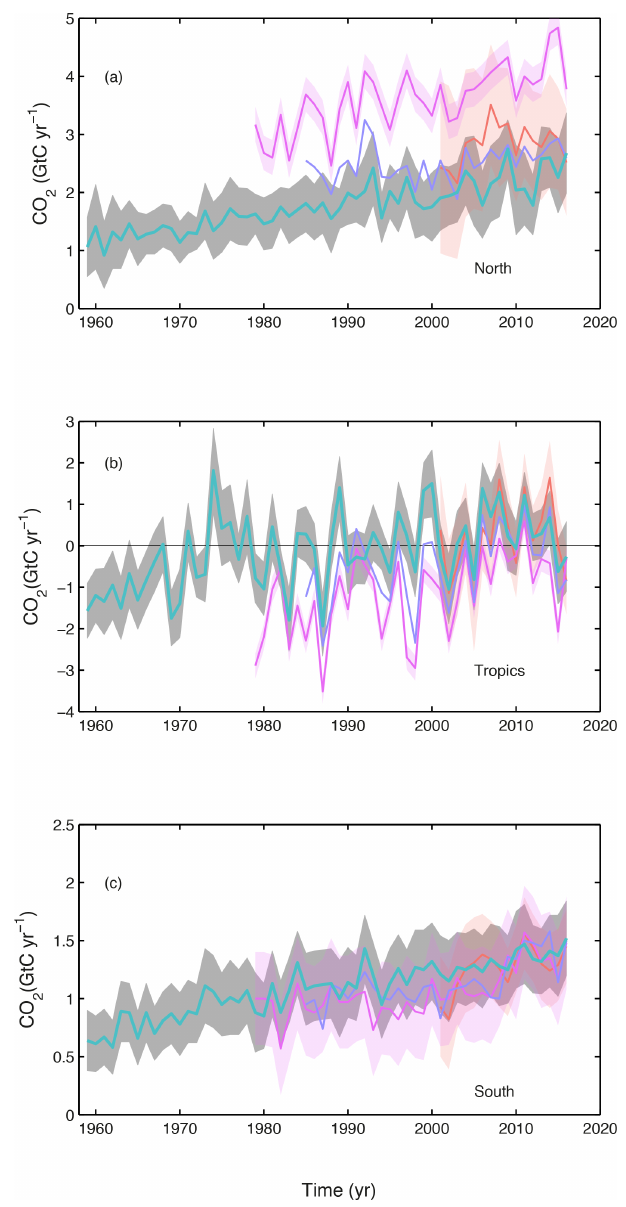
Figure 8. CO 2 fluxes between the atmosphere and the surface ( S OCEAN + S LAND − E LUC ) by latitude bands for the (a) north (north of 30 ◦ N), (b) tropics (30 ◦ S–30 ◦ N), and (c) south (south of 30 ◦ S). Estimates from the combination of the process models for the land and oceans are shown (turquoise) with ± 1 σ of the model ensemble (in grey). Results from the three atmospheric inversions are also shown (CAMS in purple, Jena CarboScope in pink, CTE in salmon; references and version number in Table 4). Where avail- able the uncertainty in the inversions are also shown. Positive values indicate a flux from the atmosphere to the land and/or ocean.